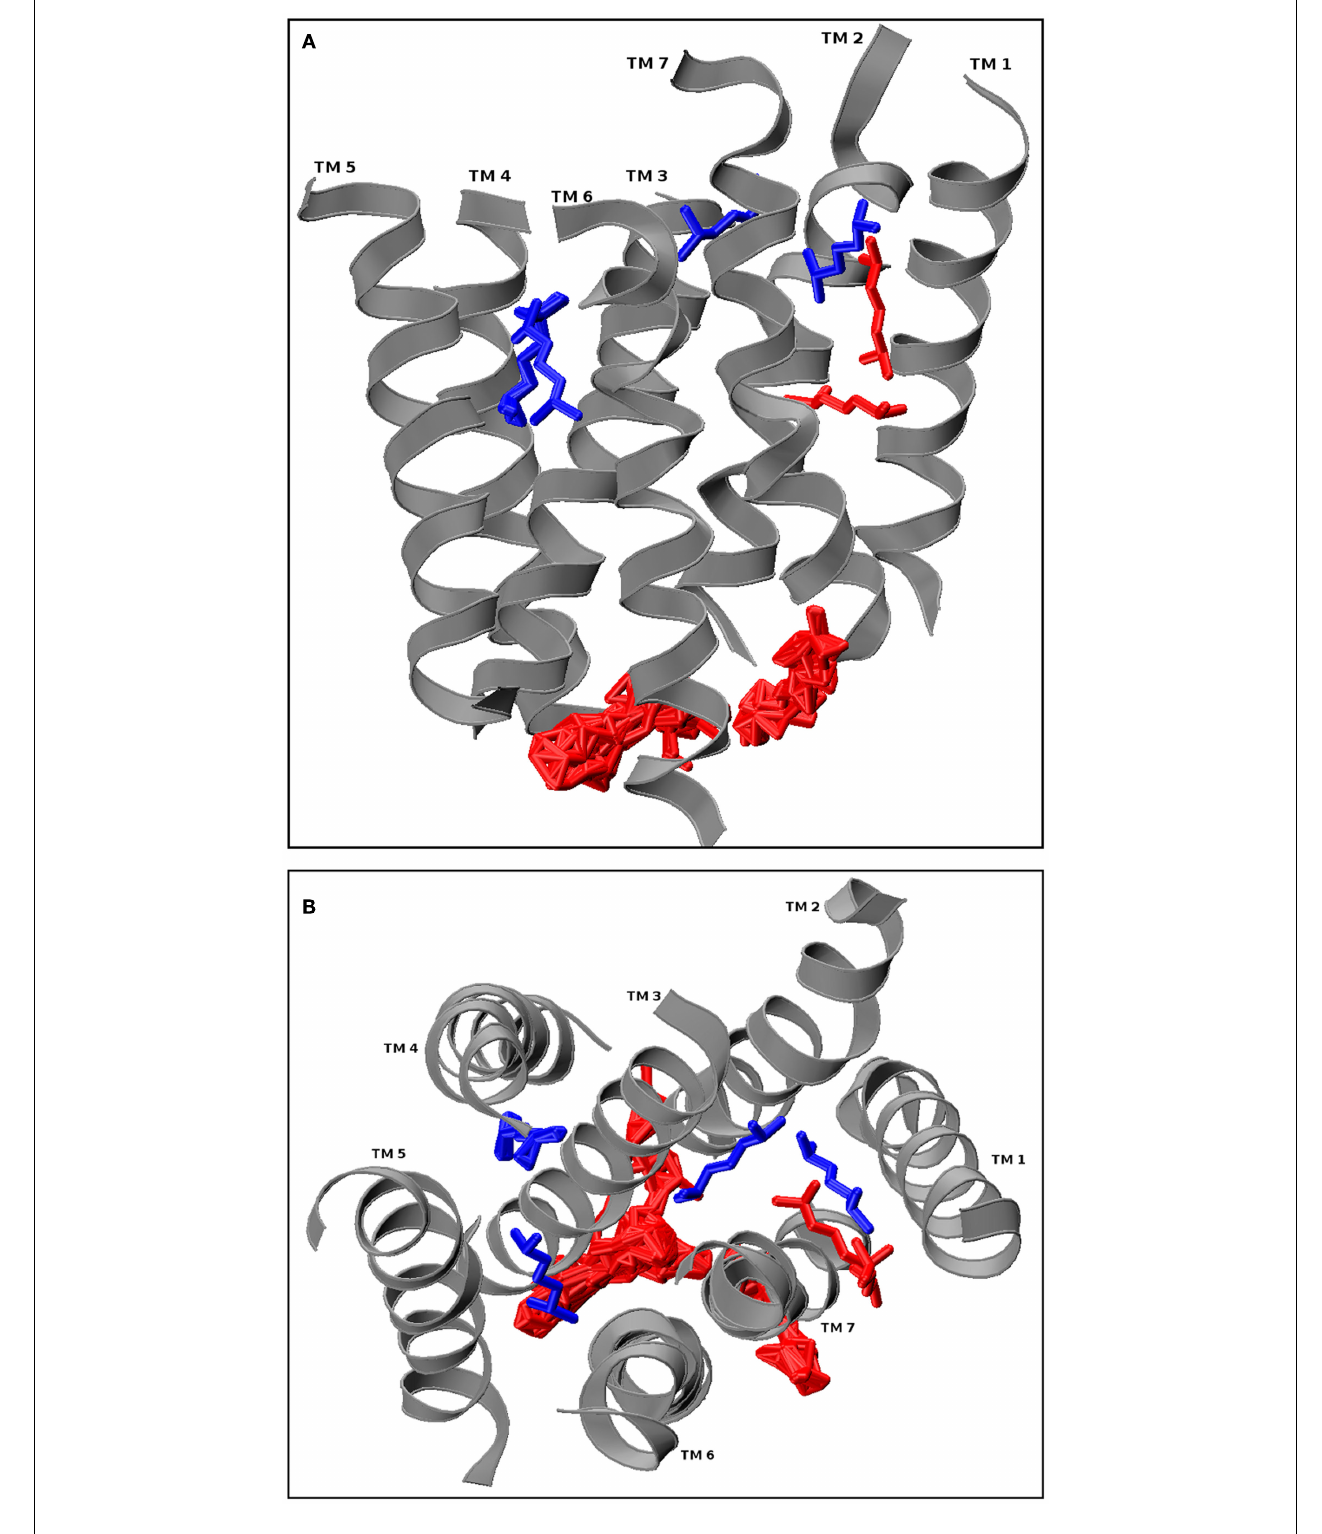
hydrophilic core) clusters are shown in blue and the discarded conformations are shown in red. One conformation from the blue cluster is selected for molecular dynamics simulation. (A) Longitudinal view. (B) Extracellular cross-section